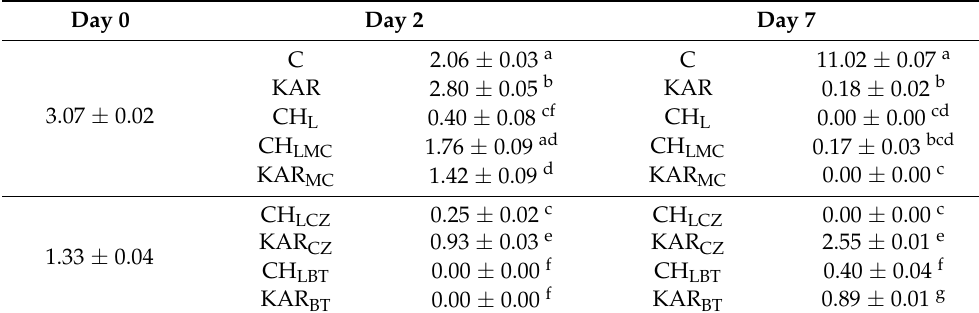
Table 4. FRAP antioxidant activity (expressed as µ mol Trolox/g) of Golden Delicious apples packaged in prepared film-forming solutions.